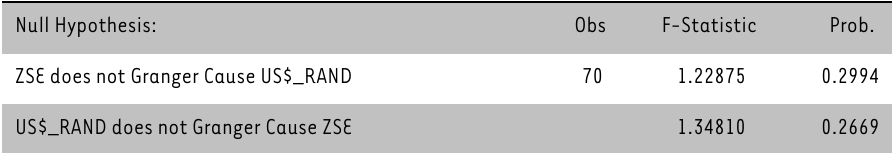
TABLE 4: Pairwise Granger Causality tests Null Hypothesis: Obs F-Statistic